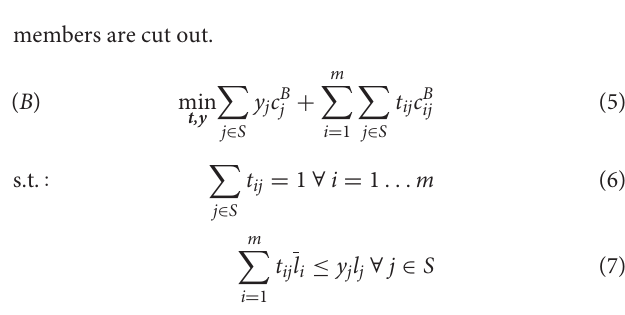
members are cut